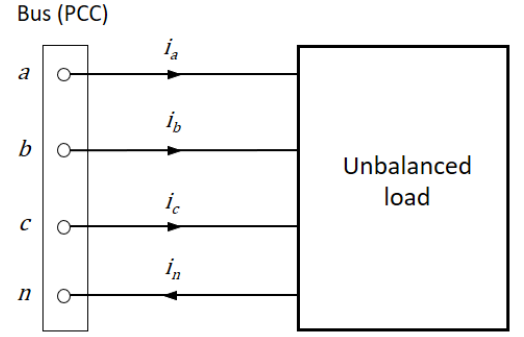
Figure 1. Three-phase four-wire system with an unbalanced load. The apparent power in the bus is determined by Equation